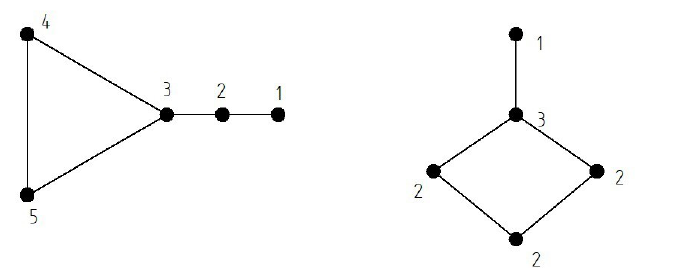
Fig. 3 Titania nanotube T i O 2 [ m , n ] with degree assigned to the